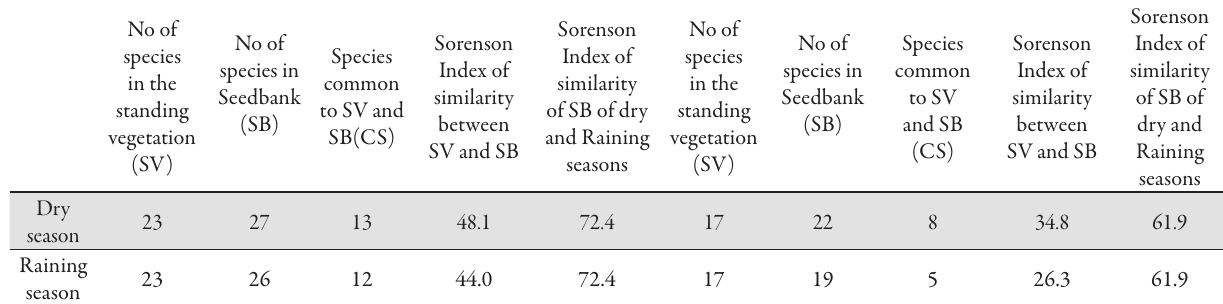
Tab. 3. Comparison of species composition and Similarity indices (based on Sorenson index) between the seedbank and the standing vegetation of the two study sites in dry and rainy